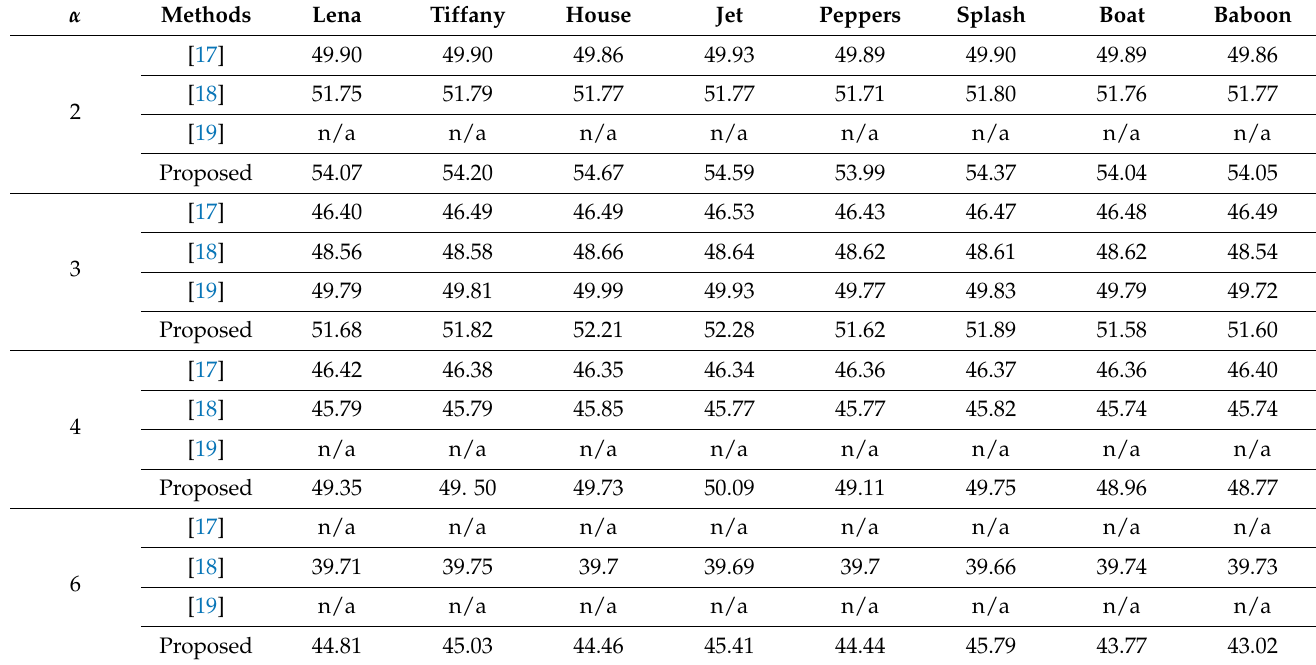
Table 4. Image quality comparisons with other works for α =